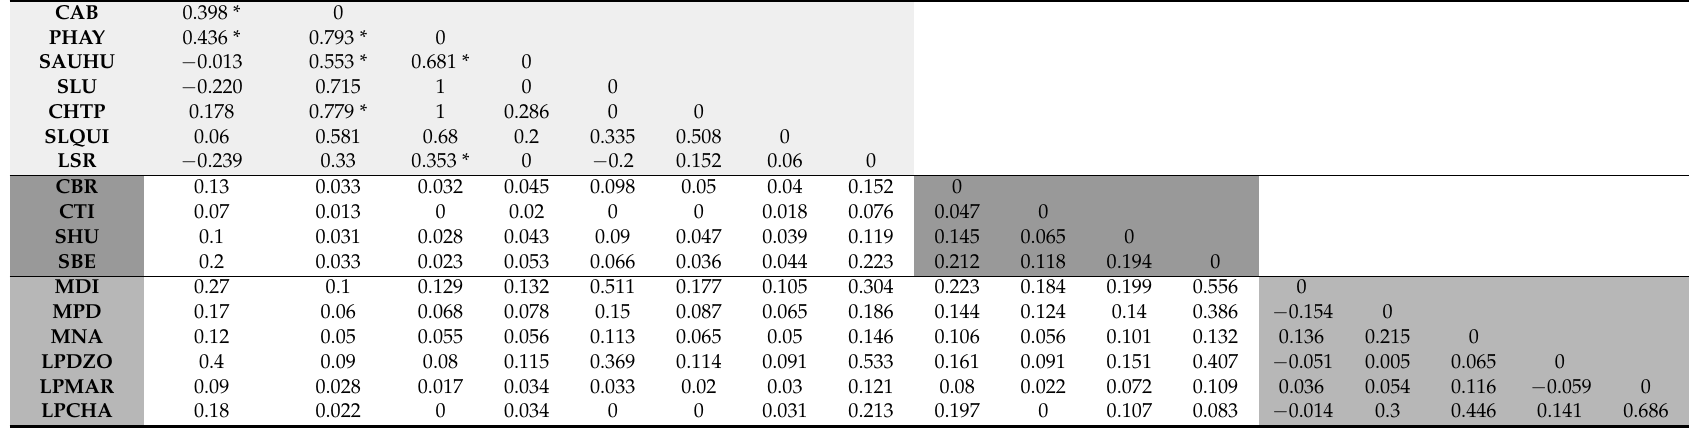
Table 3. Pairwise FST estimates among 18 Localities of H. hydnorae sampled. Inter-area contrasts are not shaded while those within areas are shaded by locality area as defined through SAMOVA analysis (Northern: light gray; Central: dark gray; Southern: medium gray). Asterisks (*) denote significance level values ( p ≤